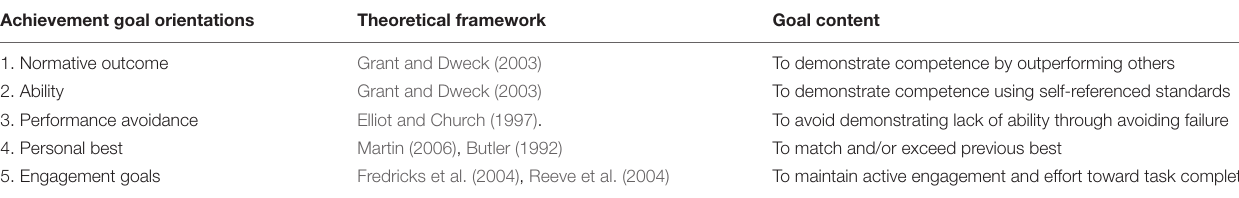
TABLE 1 | Achievement goal constructs used in the present study. Achievement goal